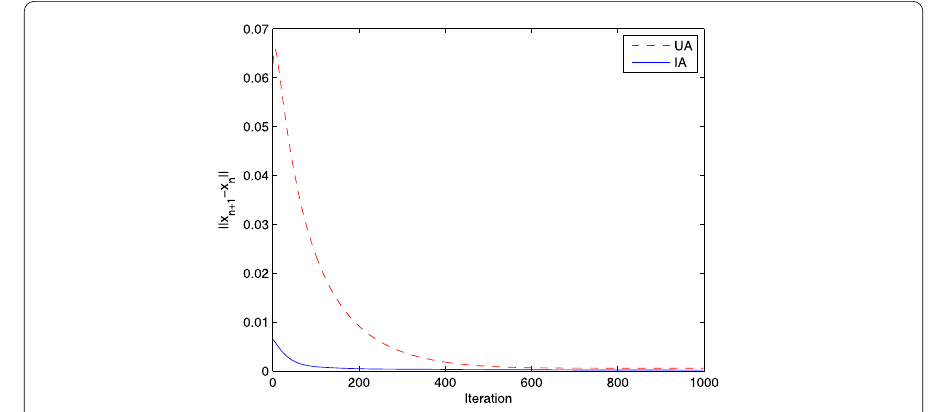
Figure 1 The comparison of (cid:4) x n +1 – x n (cid:4) of inertial acceleration (IA) and without inertial acceleration (UA) for ( M , N ) = (100,1000) of Example 4.1